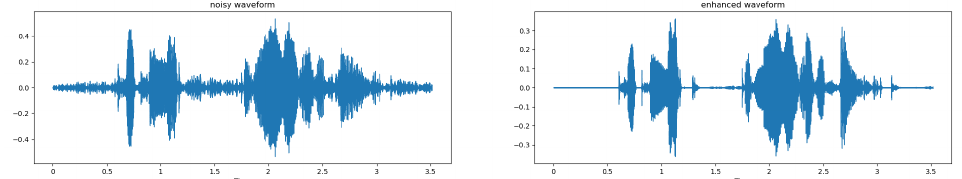
Figure 11. A comparison of the waveform plot of the noisy speech and the enhanced speech, where the left is the noisy speech and the right image is the enhanced speech.